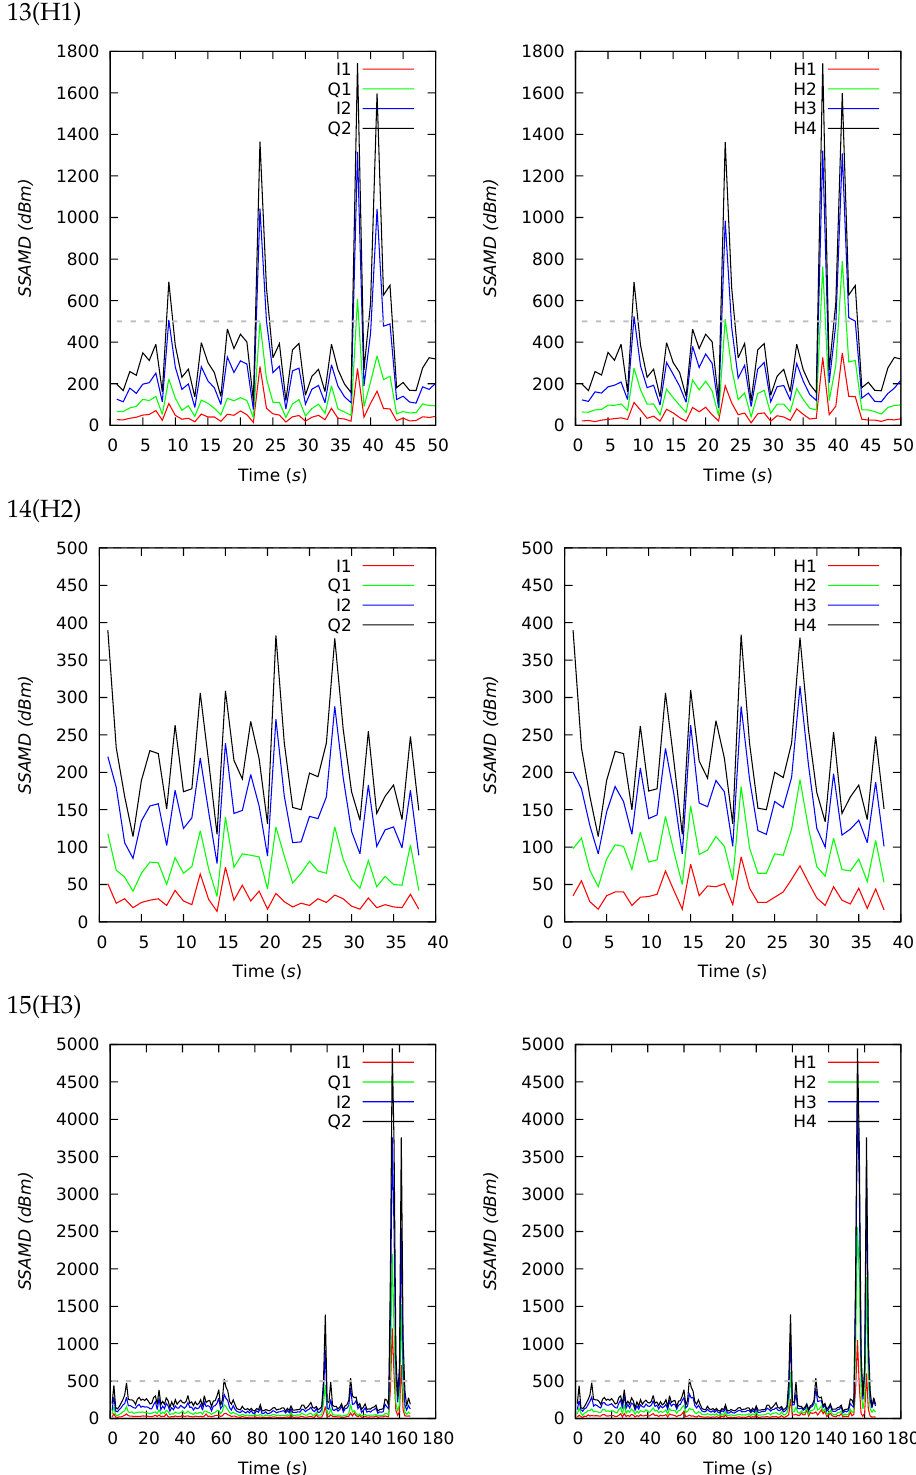
Figure A13. Experiment II, a single cricket through the diffuser (13–15